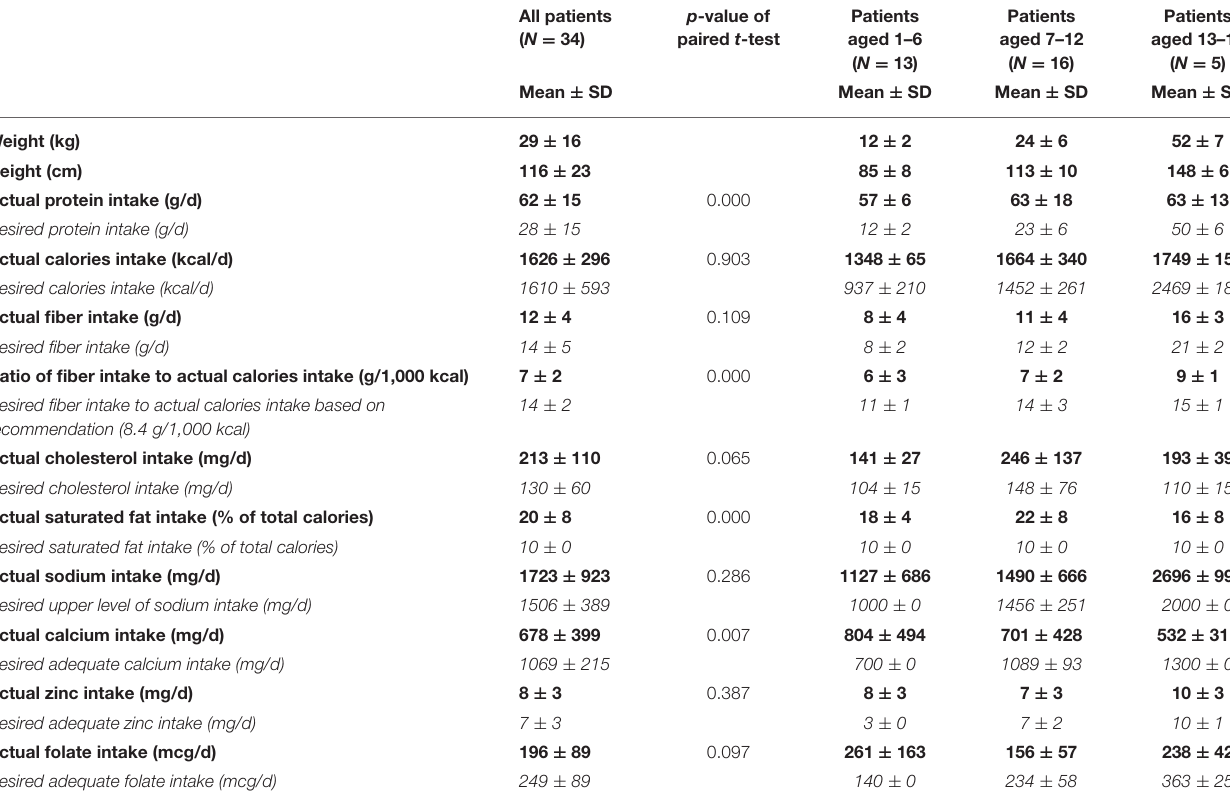
TABLE 2 | Summary of nutritional intakes and comparison with desirable